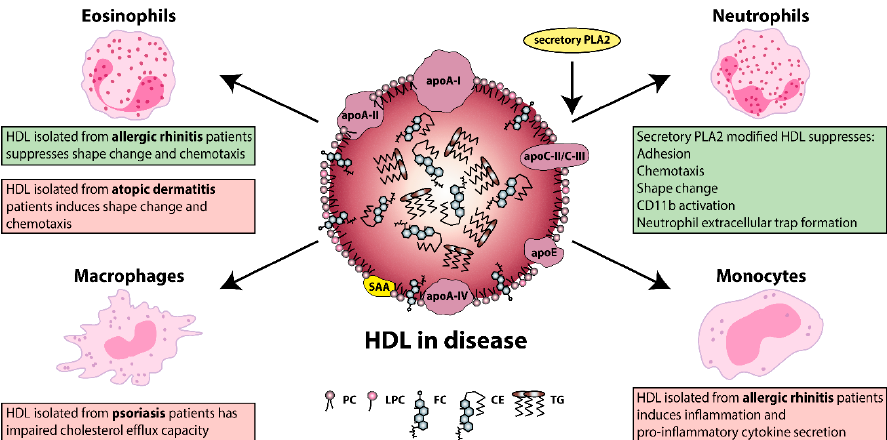
Figure 2. Overview of immunomodulating functions of HDL on different allergic and skin diseases. Figure2. OverviewofimmunomodulatingfunctionsofHDLondi ff erentallergicandskindiseases. HDL di ff erently modulates eosinophil e ff ector responses in allergic rhinitis [29] and atopic dermatitis [35]. In psoriasis, HDL showed impaired HDL-cholesterol e ffl ux capacity [30,32–34], while in allergic rhinitis HDL induced nuclear factor- κ B (NF- κ B) expression and pro-inflammatory cytokine secretion of monocytes [29]. Secretory phospholipase A2 (PLA2)-modified HDL prevented agonist-induced neutrophil activation, including shape change, cluster of di ff erentiation (CD) 11b activation, neutrophil extracellular trap (NET) formation, adhesion under flow and migration of neutrophils